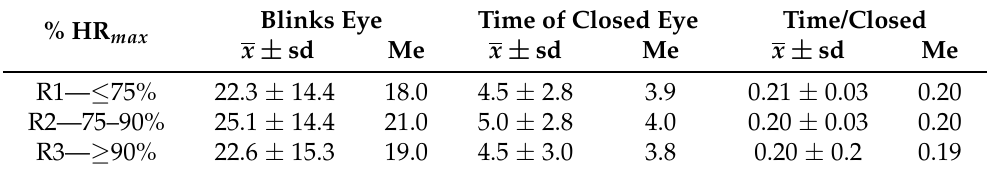
Table 3. Characteristic of analysed parameters in term of heart rate ranges.